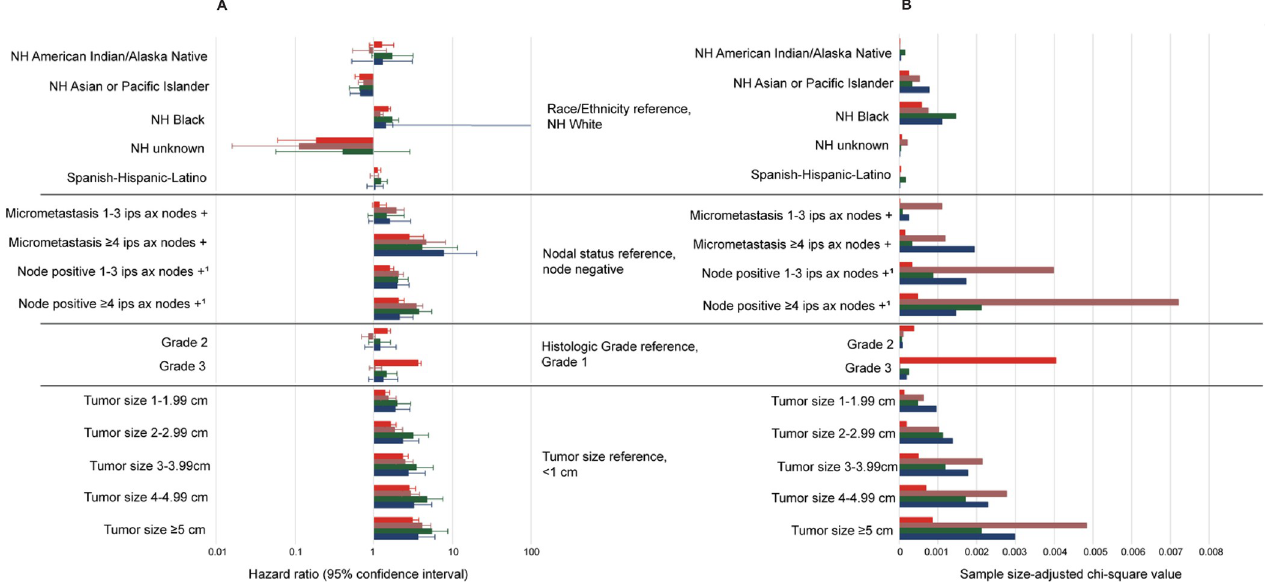
Fig 4. Breast cancer-specific mortality risk factors for patients with EBC, by HR, HER2 subtype. Hazard ratios and 95% confidence intervals (A), and sample size-adjusted Chi-square values (B) are presented for each risk factor and were derived from Cox proportional hazard models. Hazard ratios and sample-size adjusted chi-square values are additionally presented in S4 Table . 1 In these analyses, node positive was exclusive of the N1mi subgroups. Please refer to Materials and Methods section, Data Source subsection for detailed information regarding nodal status classification. Abbreviations: +, positive; AJCC, American Joint Committee on Cancer; Ax, axillary; cm, centimeter; EBC, early breast cancer; HER, human epidermal growth factor receptor; HR, hormone receptor; ips, ipsilateral; NH, non-Hispanic.